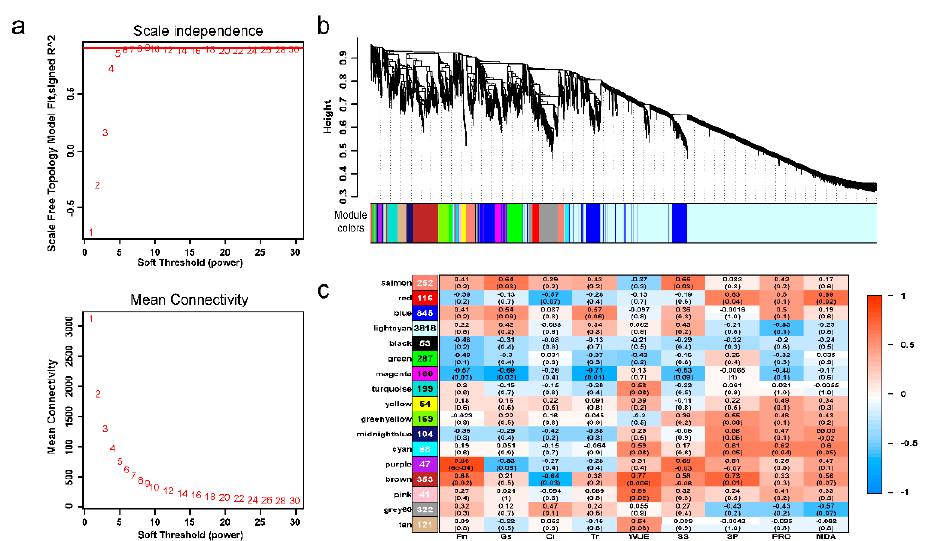
Figure 5. Construction of the WGCNA model. ( a ) Screening of soft threshold powers by network topology analysis. ( b ) Coexpression modules identified by WGCNA. The major tree branches represent 17 modules. ( c ) Module–trait correlation relationships. The number in the first row of each cell represents the corresponding correlation, and the number in parentheses represents the P-value. The color of each cell represents the correlation coefficient. The numbers in the leftmost modules represent the numbers of DEGs in this module.